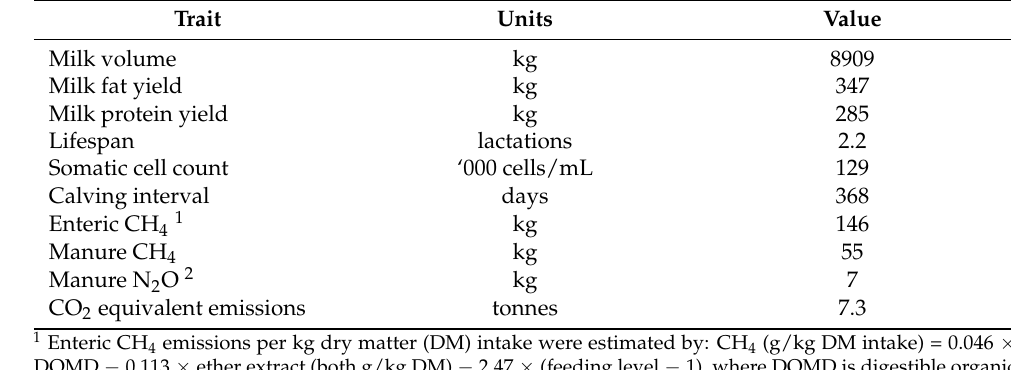
Table 1. Average production values per